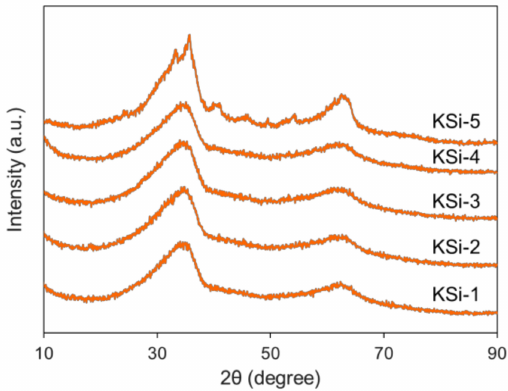
Figure 5. XRD spectra of five catalysts prepared from five different silica